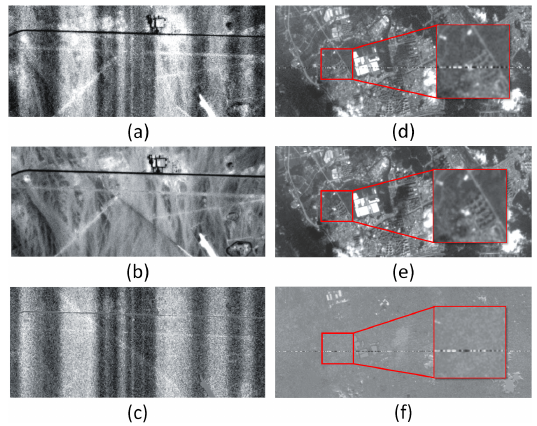
Figure 11. Denoising results using our method. (a) Original band with very large uneven stripe noise. (b) Aligned and noise-free band. (c) Separated stripe noise. (d) Original band with the damaged line on the lower middle. (e) Aligned and inpainted band. (f) Separated noise and damaged